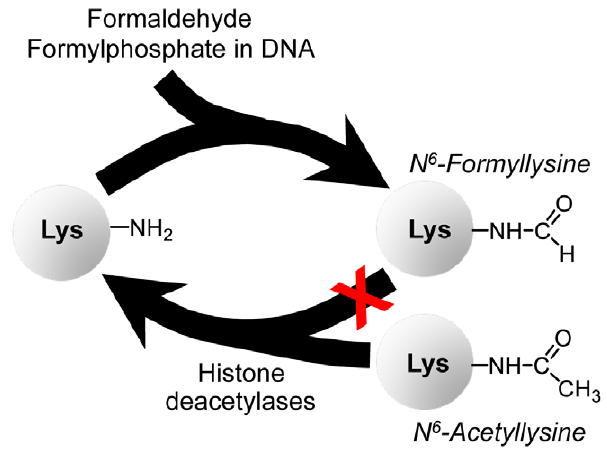
Figure 7. Summary of findings on N 6 -formyllysine in histones. N 6 -formyllysine can arise from reaction of lysine with the 3 9 -formyl phosphate residue derived from 5 9 -oxidation of 2-deoxyribose in DNA or from reaction of lysine with formaldehyde. Furthermore, our data suggest that N 6 -formyllysine is refractory to removal by histone deacetylases, which is consistent with the persistence of this pathological adduct throughout the life of individual histone proteins.